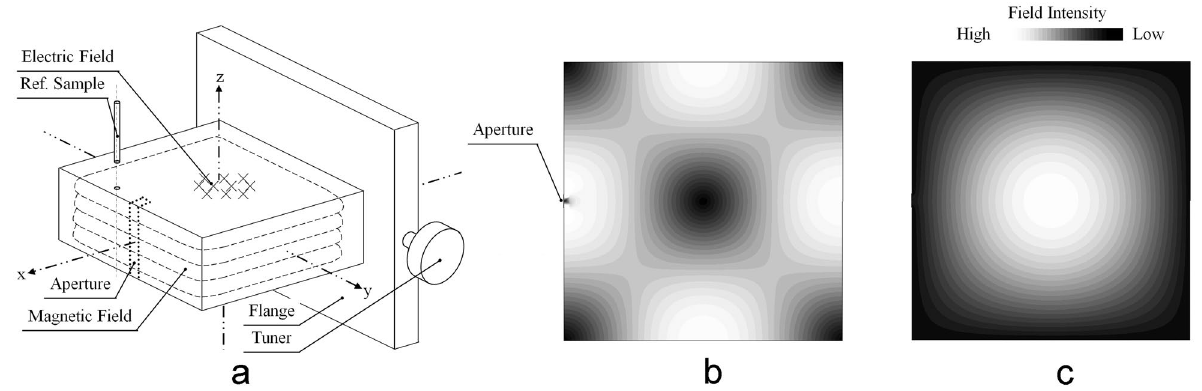
Figure 2. The cavity design. ( a ) The sketch of the aperture cavity for in-vivo EPR fingernail dosimetry. ( b ) Magnetic field distribution in the XOY plane. ( c ) Electric field distribution in the XOY plane.